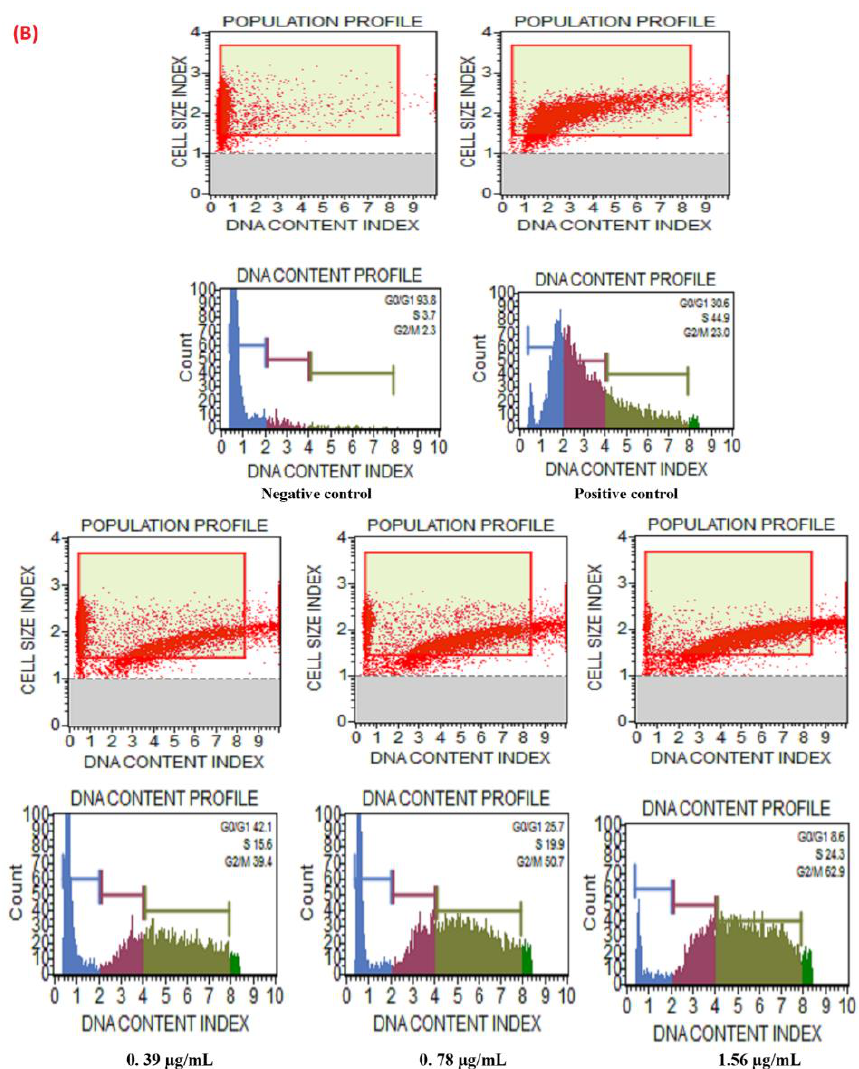
Figure 9. Cell cycle analysis of C. auris by Muse™ Cell Analyzer. ( A ) Figure showing effect of the Ag-Cu-Co trimetallic nanoparticle at ½ MIC (0.39 µg/mL), MIC (0.78 µg/mL) and MFC (1.56 µg/mL) on cell cycle progression in C. auris MRL 6057. Cells exposed to H 2 O 2 (10 mM) were considered positive control, whereas untreated cells are negative control. ( B ) Representative histograms were obtained from Muse TM Cell Analyzer for exposed and unexposed C. auris cell cycle, representing the effect of nanoparticles on cell cycle and cell size index. *** p ≤ 0.05.